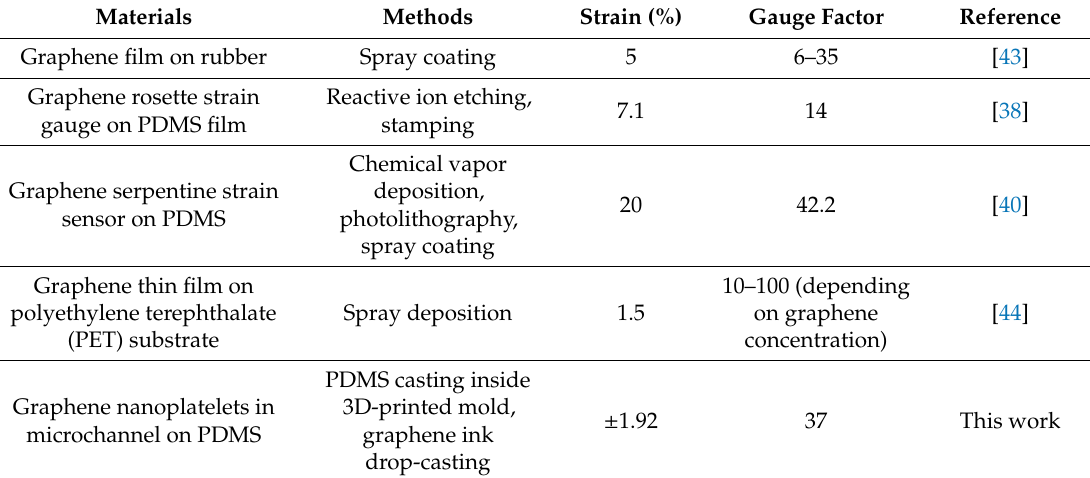
Figure 4. Gauge factor measurement: ( a ) schematic of tensile test setup to measure resistance for an applied strain (blue: PDMS, yellow: graphene); and ( b ) applied strain profile and measured resistance change for 10 tension-compression cycles. Table 1. Comparison with gauge factor values in the literature.